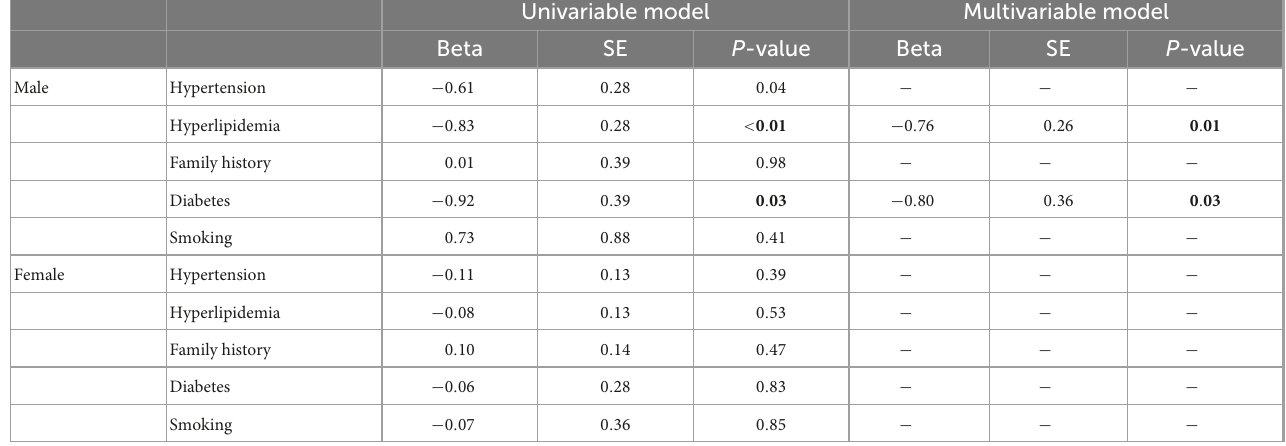
TABLE 2 Associations of traditional cardiovascular risk factors with myocardial perfusion reserve index